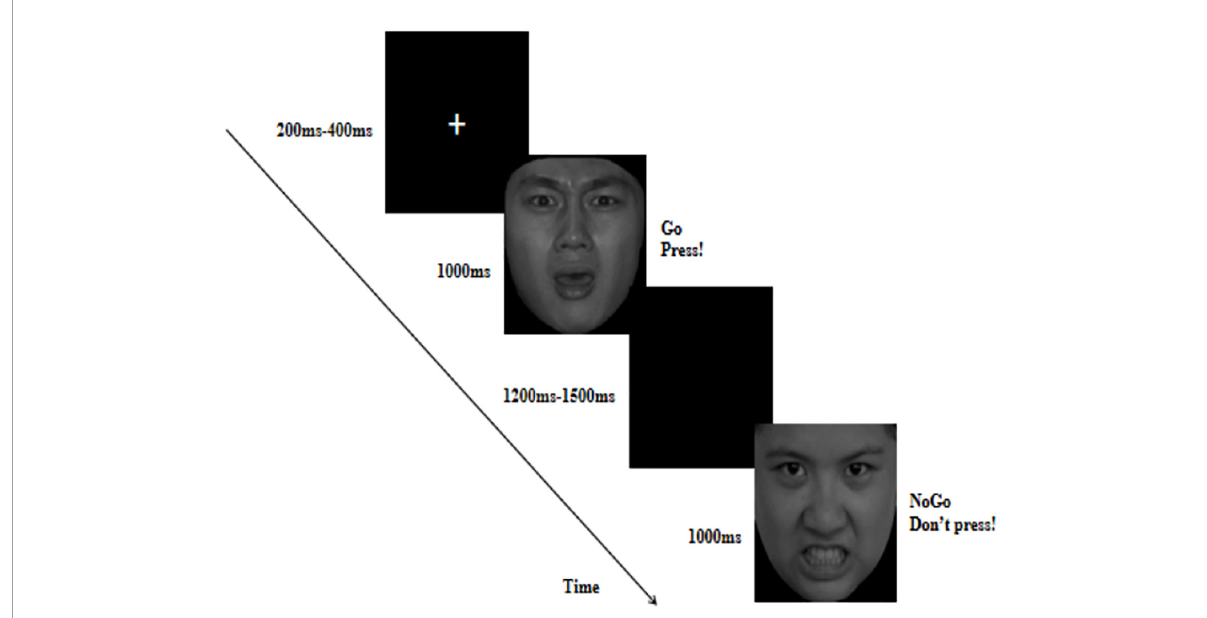
FIGURE1 The flow map of emotional Go/No-Go task in which fearful faces served as Go cues and angry faces served as No-Go cues. Fearful and angry facial images reproduced with permission from Chinese Facial Affective Picture System (Wang and Luo, 2005).